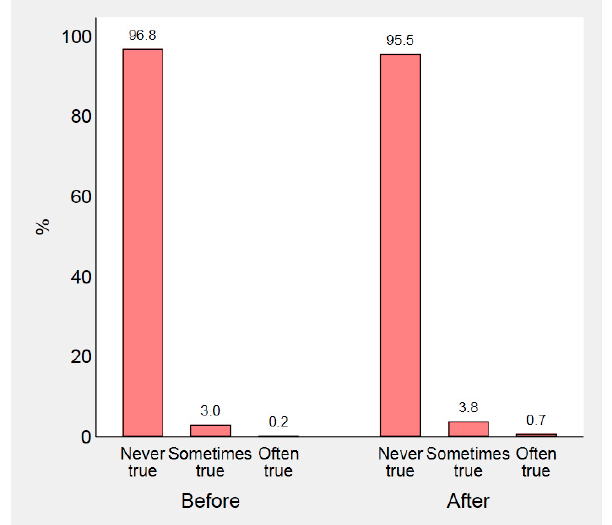
Figure 2. Frequency with which parents ran out of food and did not have enough money to buy more, before and after COVID-19 outbreak.